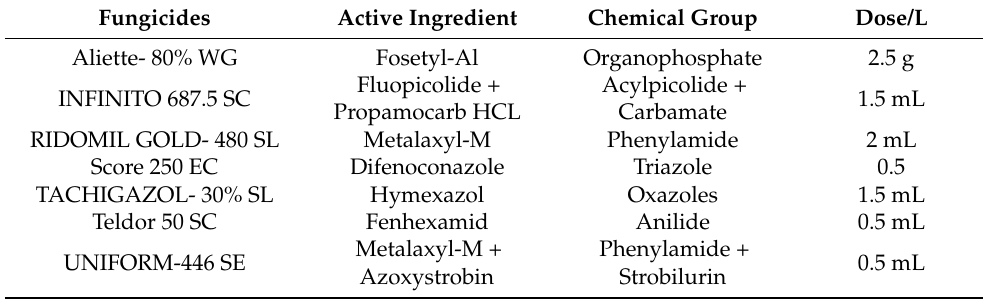
Table 4. List of fungicides and their characteristics used to curtail black scorch disease in date